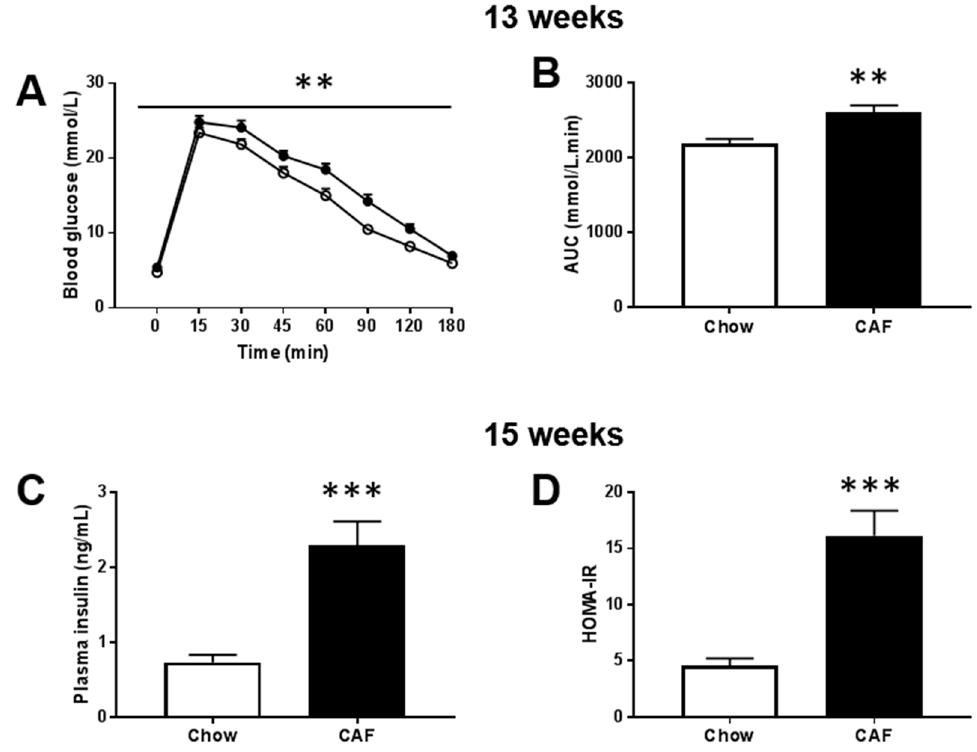
Figure 2. Intraperitoneal glucose tolerance test (ipGTT) at 13 weeks and plasma insulin concentrations and homeostatic model assessment of insulin resistance (HOMA-IR) at cull (15 weeks). ( A ) Glucose excursion curves up to 180 min of chow and CAF rats during ipGTT ( n = 14 chow, 12 CAF; two-way ANOVA (group × time) indicated main effects of time (F (7, 168) = 365.32, p < 0.001) and group (F (1, 24) = 12.93, p = 0.001) and interaction (F (7, 168) = 2.061, p = 0.050). ( B ) Area under curve (AUC) for ipGTT (180 min; n = 14 chow, 12 CAF, p = 0.01; unpaired t test). Glucose injections were unsuccessful for two rats in the CAF group and thus did not generate data for a glucose response, leaving 14 chow and 12 CAF rats in panels A–B. ( C ) Plasma insulin concentrations ( n = 14/group, p < 0.001). ( D ) HOMA-IR, marker of insulin resistance measured based on fasting glucose and insulin at cull ( n = 14/group, p < 0.001). Insulin and HOMA-IR data were analyzed by a non-parametric Mann–Whitney U test. The open circle or bar indicates chow group while the filled circle or bar indicates the CAF group. (** p < 0.01; *** p < 0.001 versus chow).